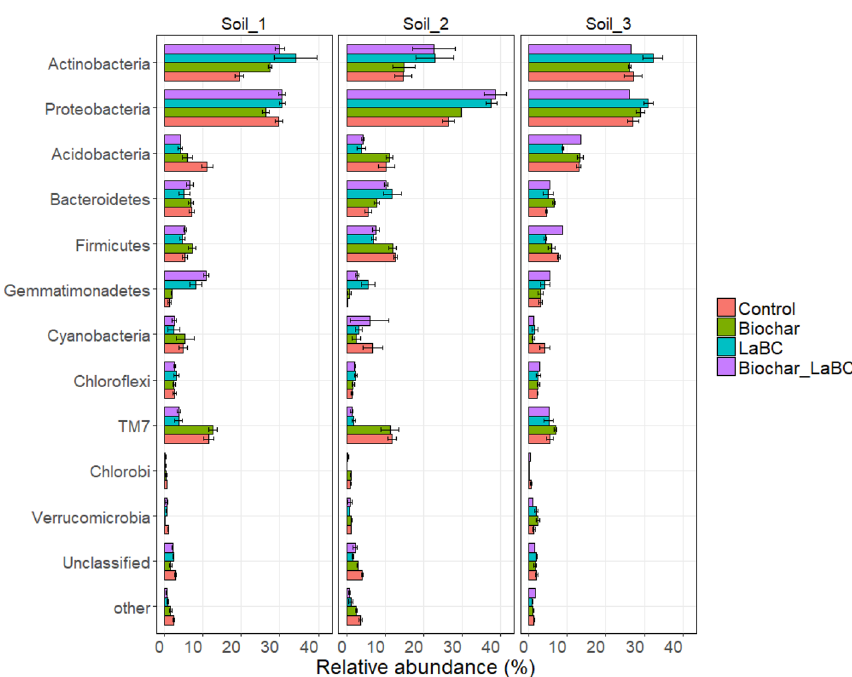
Figure 2. Relative abundance of bacterial phyla for three soils of contrasting textures (Soils 1, 2 and 3; sand, sandy loam and clay respectively) amended with LaBC, Biochar and Biochar + LaBC or unamended (control) after 8 weeks with subterranean clover. Error bars represent standard errors (n =